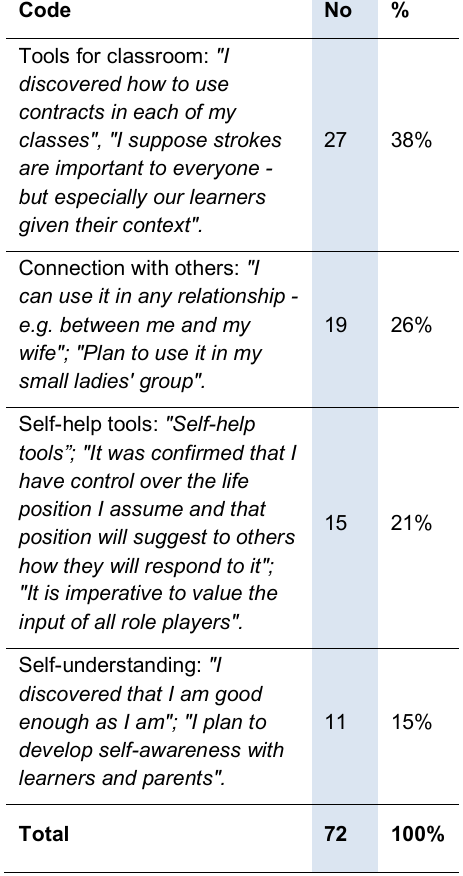
Table 3: Coding Frame: Impact of TA Intervention